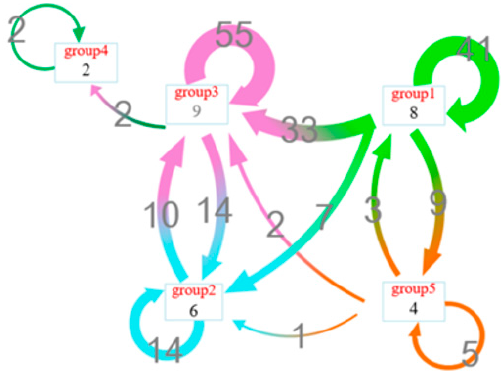
Figure 21. Interaction pattern representation of layer2.